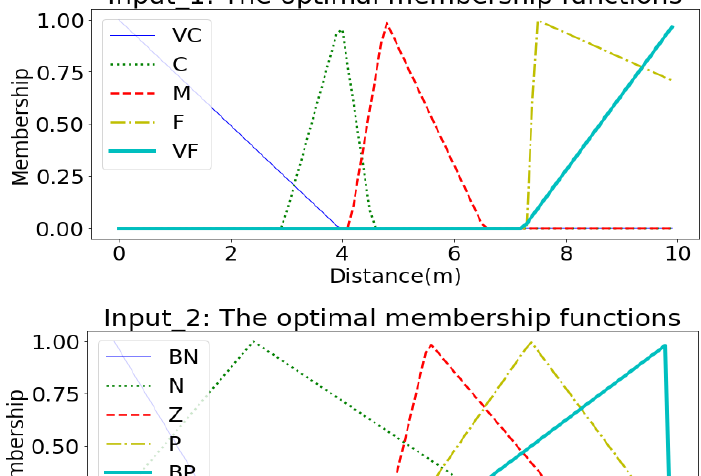
Figure 13. The convergence of the fitness value over generations.